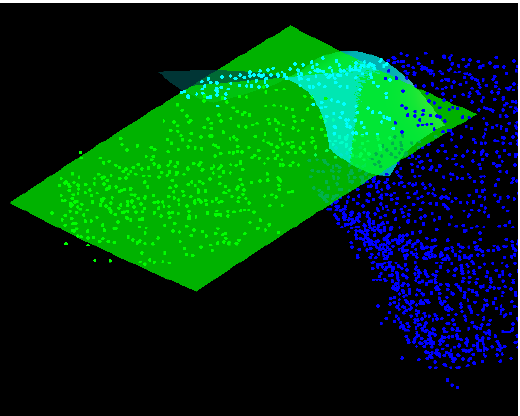
Figure 6. Surface-based region merging: the parameters of best-fitting second-order surfaces are statistically tested for equality.